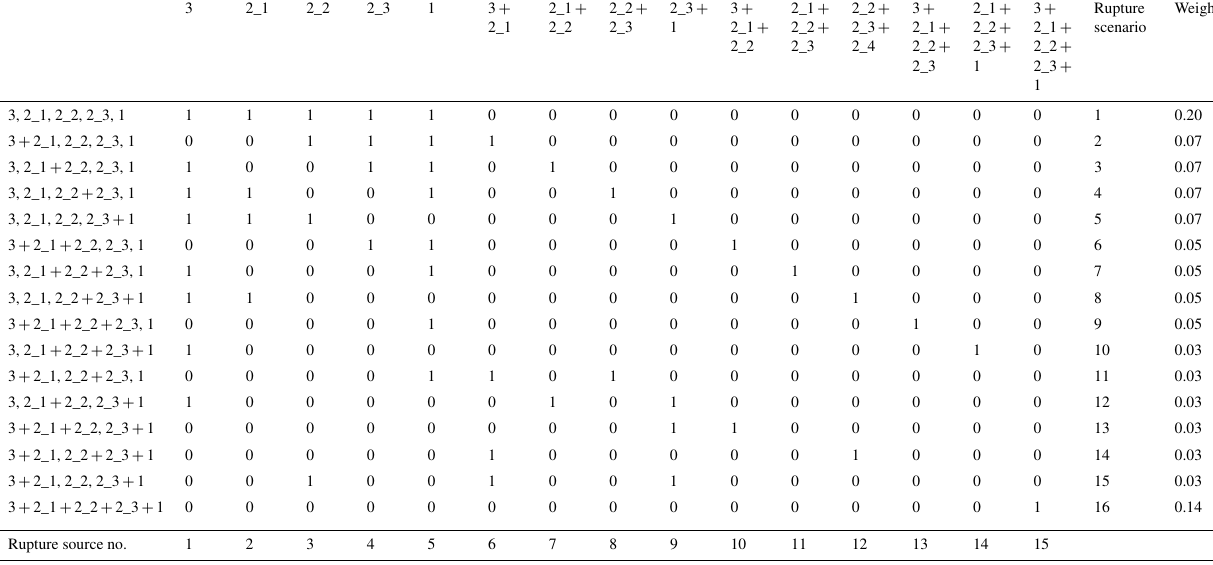
Table 5. Rupture sources and rupture scenarios utilized for the Izmit rupture system a